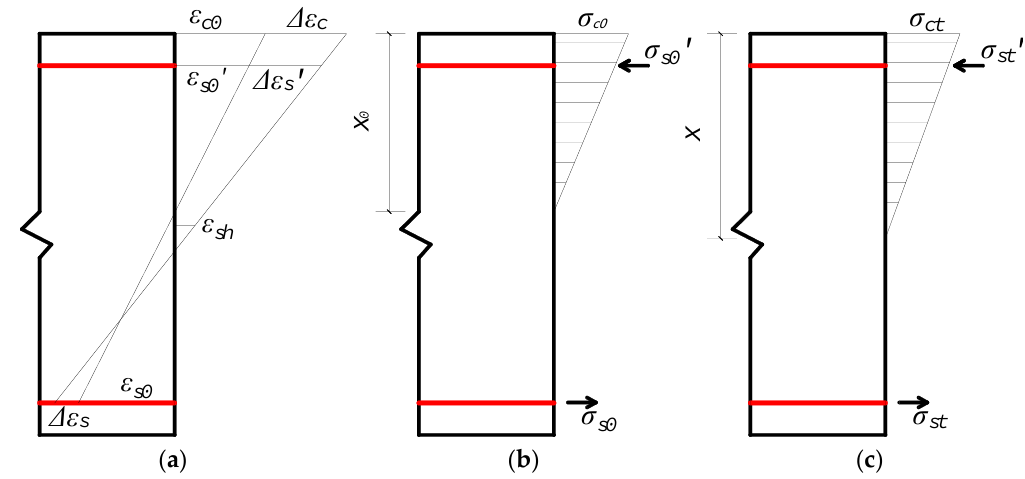
Figure 15. Stress–strain distribution relationship of the beam section. ( a ) Strain of the beam section at t 0 and t ; ( b ) stress of the beam section at t 0 ; ( c ) stress of the beam section at t. t 0 is defined as the initial moment when the beam is loaded to a stable long-term load, and t is any time point in the long-term loading process. In the process of loading, the tensile and compression bars endure a fixed bending moment. Due to the e ff ect of shrinkage and creep, the concrete strain in the compression zone increases with time, but the reinforcement will not shrink or creep.